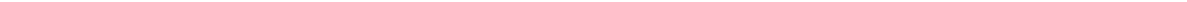
Fig. 7 Microcluster composition before and after VAMP7 recruitment. a – c Jurkat cells were transfected with a LAT-Halo, Grb2-scarlet, and emerald- VAMP7, b LAT-ruby, PLC γ 1-Halo, and emerald-VAMP7, or c LAT-ruby, SLP76-Halo, and emerald-VAMP7, dropped onto stimulatory coverslips, and imaged by TIRF microscopy. Indicated time points are shown with t 0 corresponding to the earliest observable time point. For each time point, the upper- right image was magni fi ed from the region marked by a white box in the left image, and the bottom-right graph shows the relative fl uorescence intensity (RFI) measured across the width of the white line in the corresponding upper-right image. a – c Scale bars in left images equal 2 μ m. Scale bars in upper-right images equal 0.5 μ m ( n = 6 cells for Grb2, 4 cells for PLC γ 1 and SLP-76; three independent experiments). d , e Left panels show time-lapse montage at 3 s/ frame graphs of a single microcluster and kinetics of recruitment of LAT, Grb2, and VAMP7. On the right, relative fl uorescence intensity (RFI) plots of the time-lapse montage are shown. Blue arrowheads indicate peak VAMP7 fl uorescence, red arrowheads indicate peak Grb2 fl uorescence ( d) or increased Grb2 fl uorescence once VAMP7 is recruited ( e) and green arrowheads indicate peak LAT fl uorescence ( d) or increased LAT fl uorescence post VAMP7 recruitment ( e) . Scale bars equal 0.5 μ m. See also Supplementary Figure